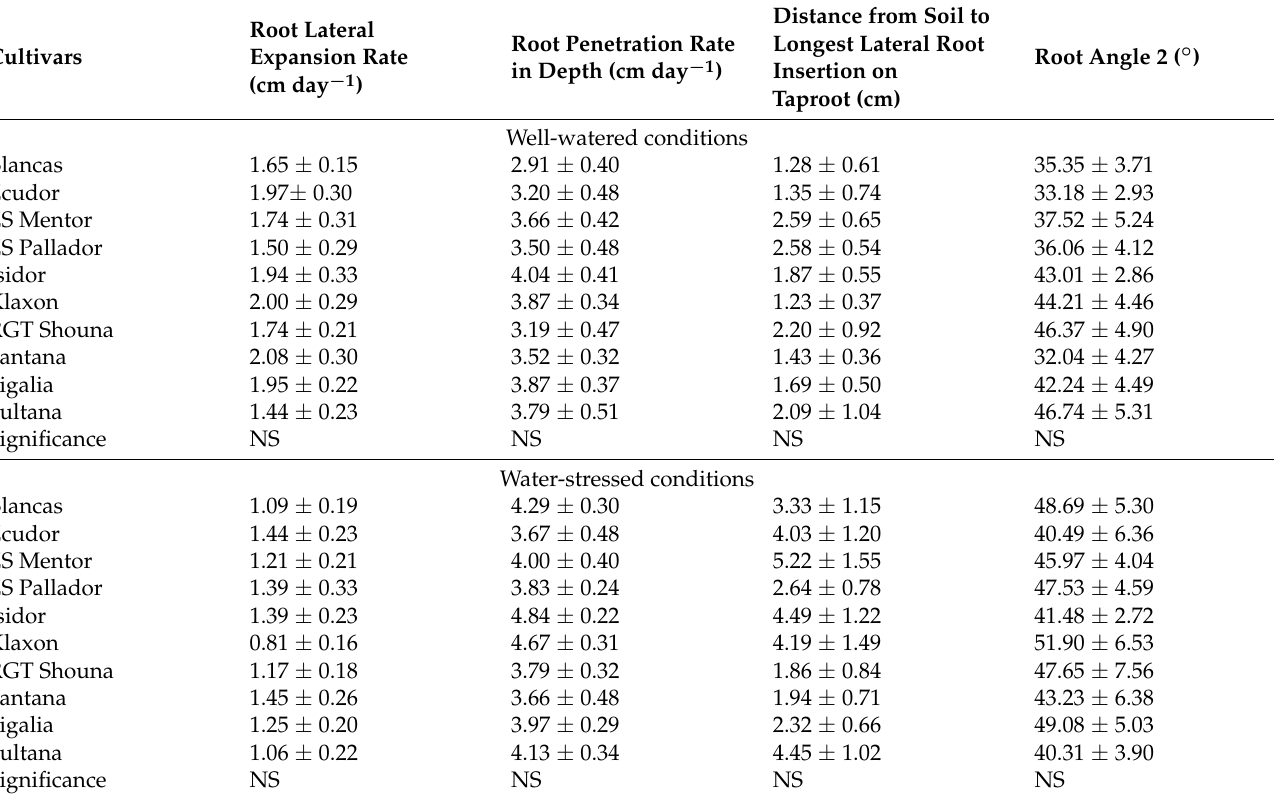
Table A3. A comparison of root architectural traits in ten soybean cultivars under well-watered and water-stressed conditions.